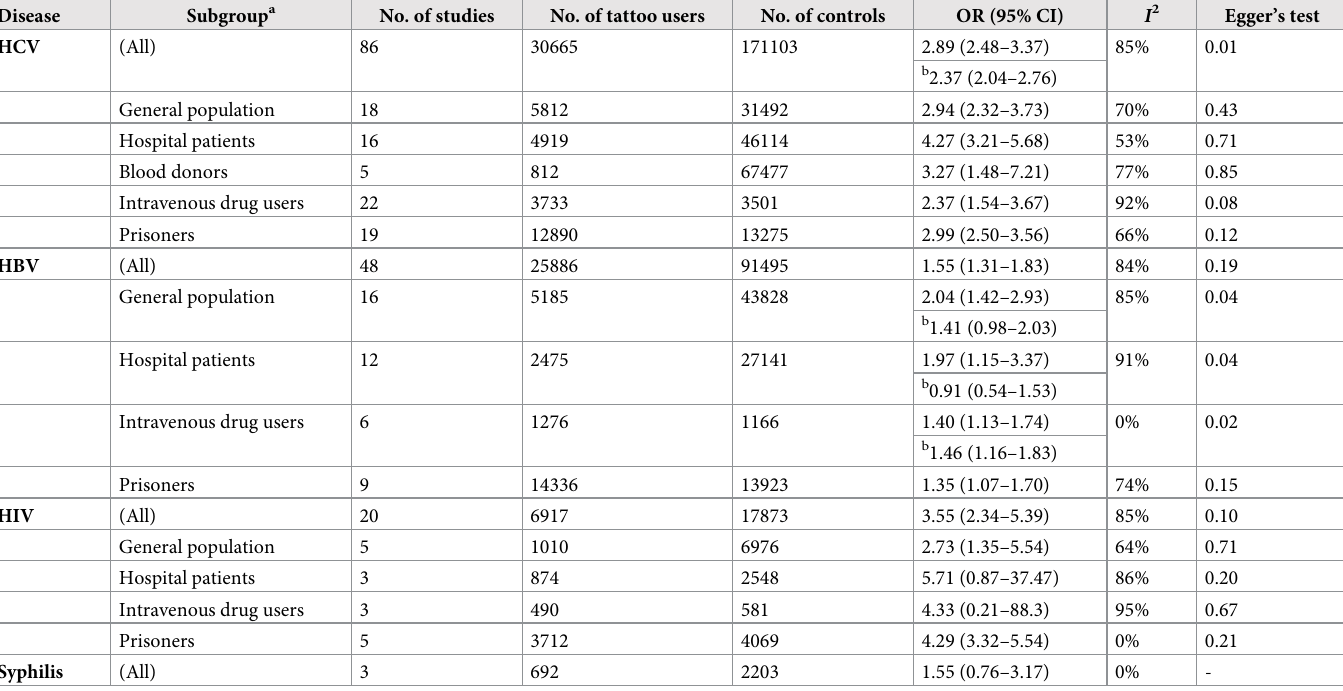
Table 2. Meta-analyzed estimates of the prevalence rates of transfusion-transmitted diseases among subjects with tattoos. Disease Subgroup